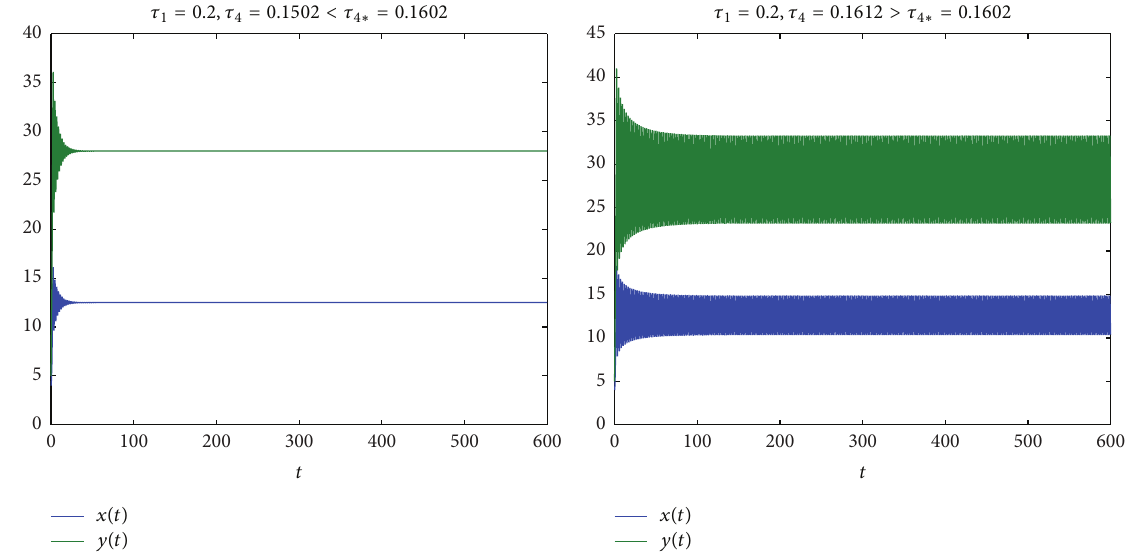
Figure 5: MATLAB simulation shows that the bifurcating periodic solutions from 𝐸 ∗ occur for 𝜏 4 = 0.1612 > 𝜏 4∗ = 0.1602 with 𝜏 1 = 0.2 and initial value “0.4, 0.5.”